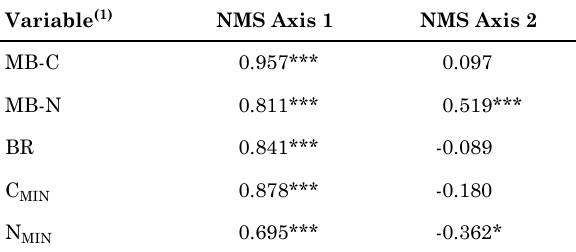
Table 3. Correlation coefficients (r) between soil microbial properties and NMS axis